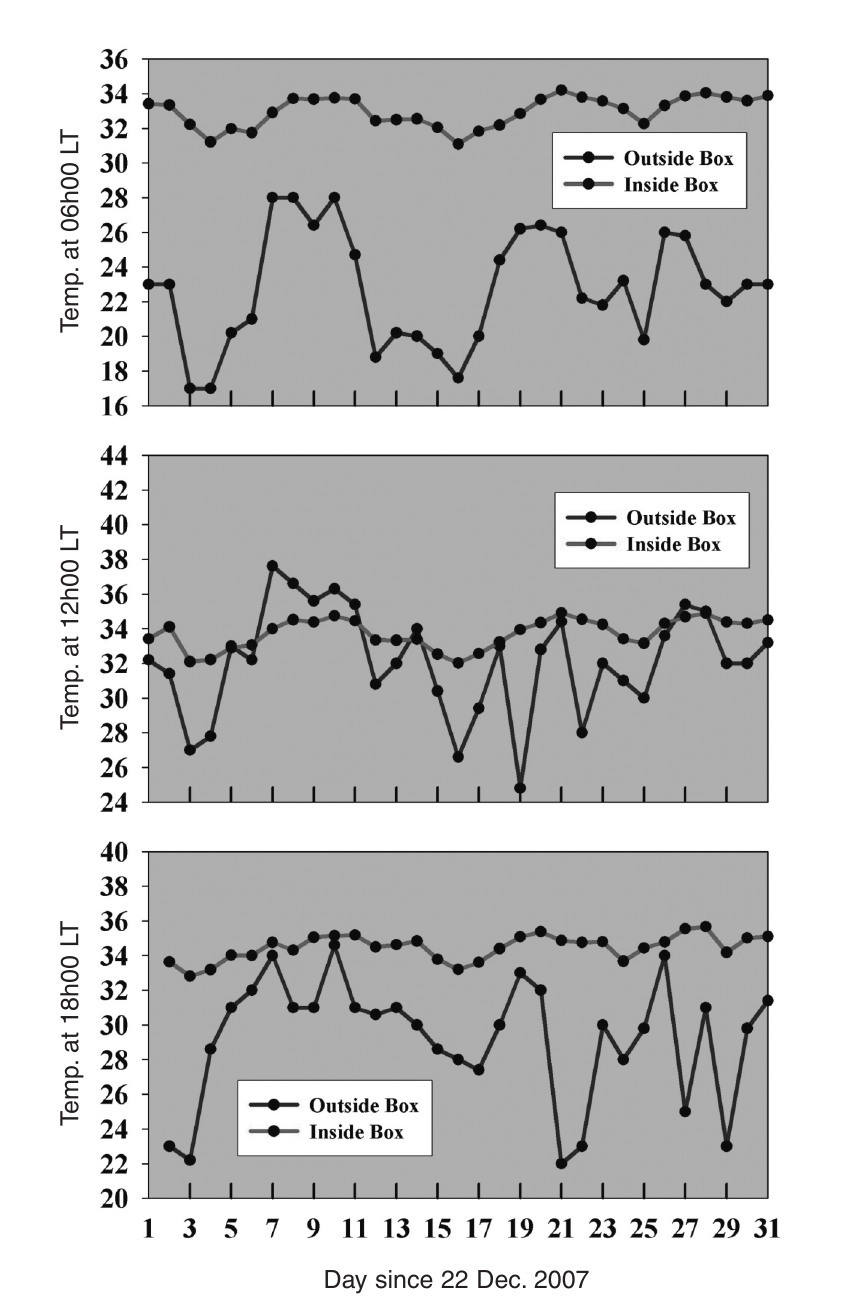
Fig. 6. The temperature variation at KMH Observatory as recorded inside the instrumentation box (grey curves) as well as measured outside by the Meteorological Office at the Keetmanshoop Airport at different times of the day (06h00,12h00, and18h00LT). Data shown are from 23 December 2007 till 22 January